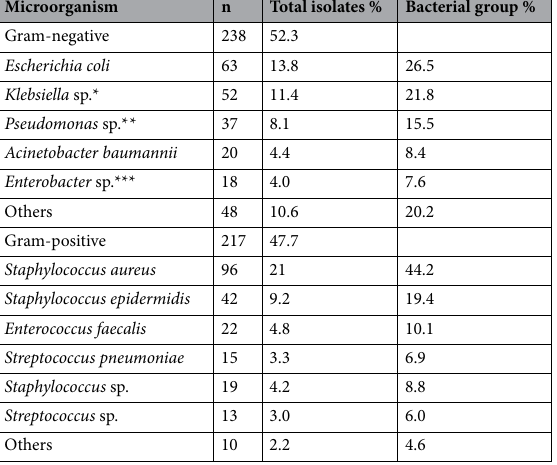
Table 2. Microorganisms isolated from patients with positive blood cultures Gram-negatives or Gram- positives. *Includes 33 P. aeruginosa 4 P. Putida. **Includes 47 K. pneumoniae 5 K. Oxytoca. ***Includes 17 E. cloacae 1 E. aerogenes.